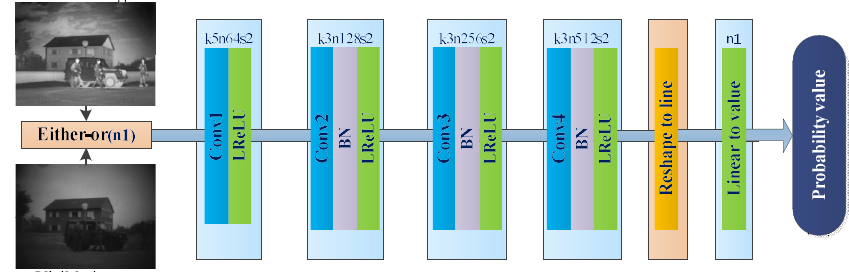
Figure 5. The network structure of discriminator.